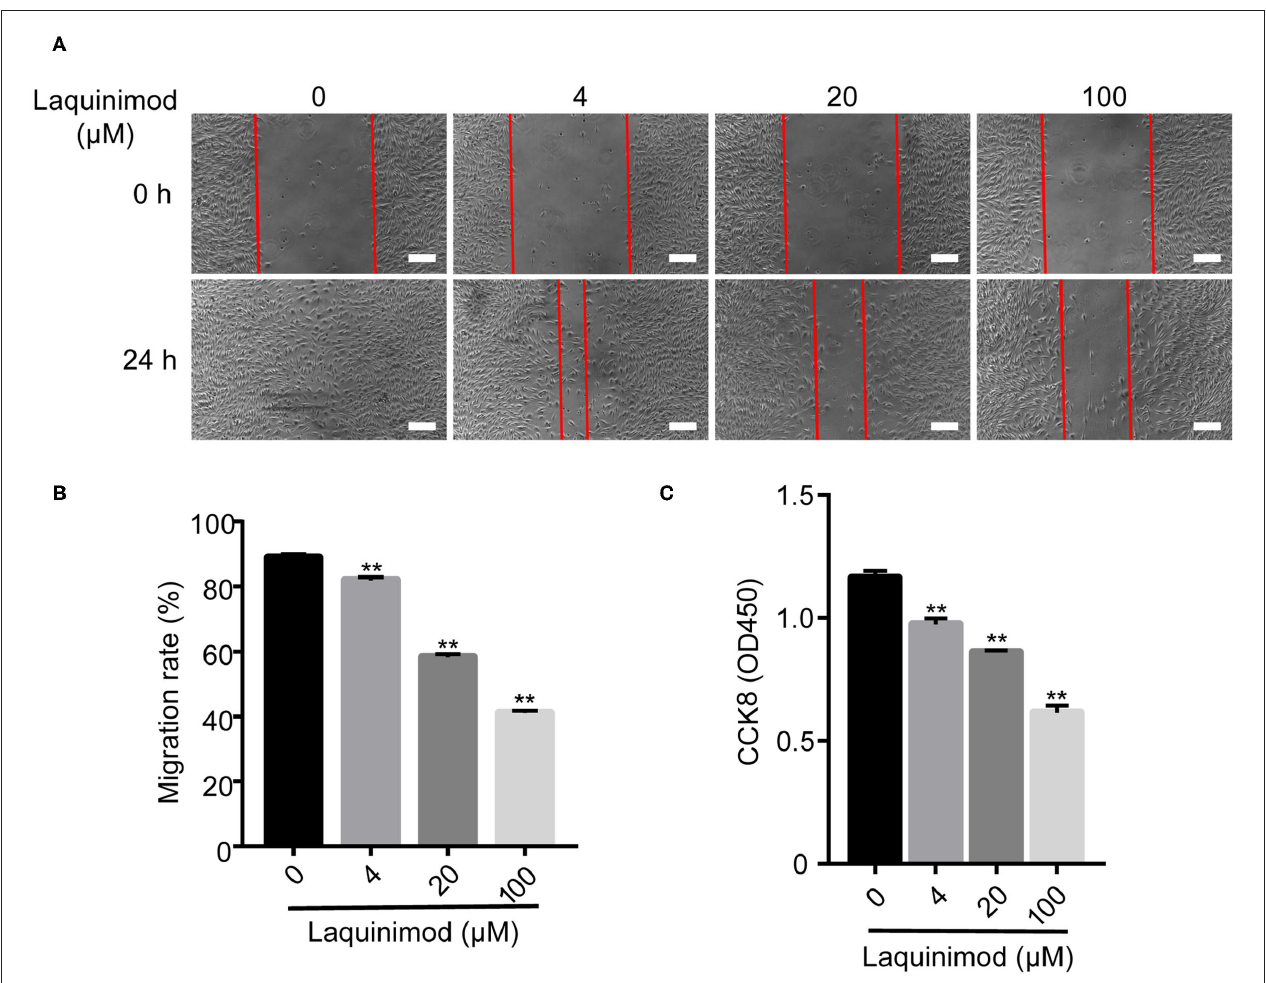
FIGURE 5 | Inhibition of HUVEC proliferation and migration by laquinimod. (A) Images of HUVEC migration, which were assessed in a scratch assay, were captured at the same position at 0, 12, and 24h after incubation with migration assay buffer containing laquinimod or PBS. Scale bars = 100 µ m. (B) The area of the wound was calculated with ImageJ software. (C) HUVECs (1 × 10 5 ) were cultured in the presence of laquinimod at 37 ◦ C in a CO 2 incubator, and cell proliferation was determined by a CCK-8 assay. The results from one representative experiment of four are shown (in triplicate). PBS as control, ** p < 0.01, laquinimod vs. PBS-treated